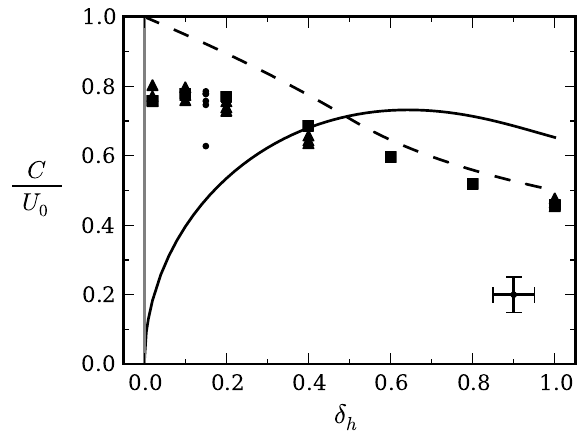
Fig. 2. Initial intrusion speeds in ambients with piecewise linear (squares) and hyperbolic tangent (triangles) profiles. These numer- ically computed speeds (as discussed in Sect. 3.2) are compared to the predicted rectilinear speed (dashed line) defined by Eq. (4) and the linear long wave speed (solid line) defined by Eq. (11). Experimental speeds, measured by Sutherland and Nault (2007), are plotted as circles. The largest experimental error bars are also shown in the lower right hand